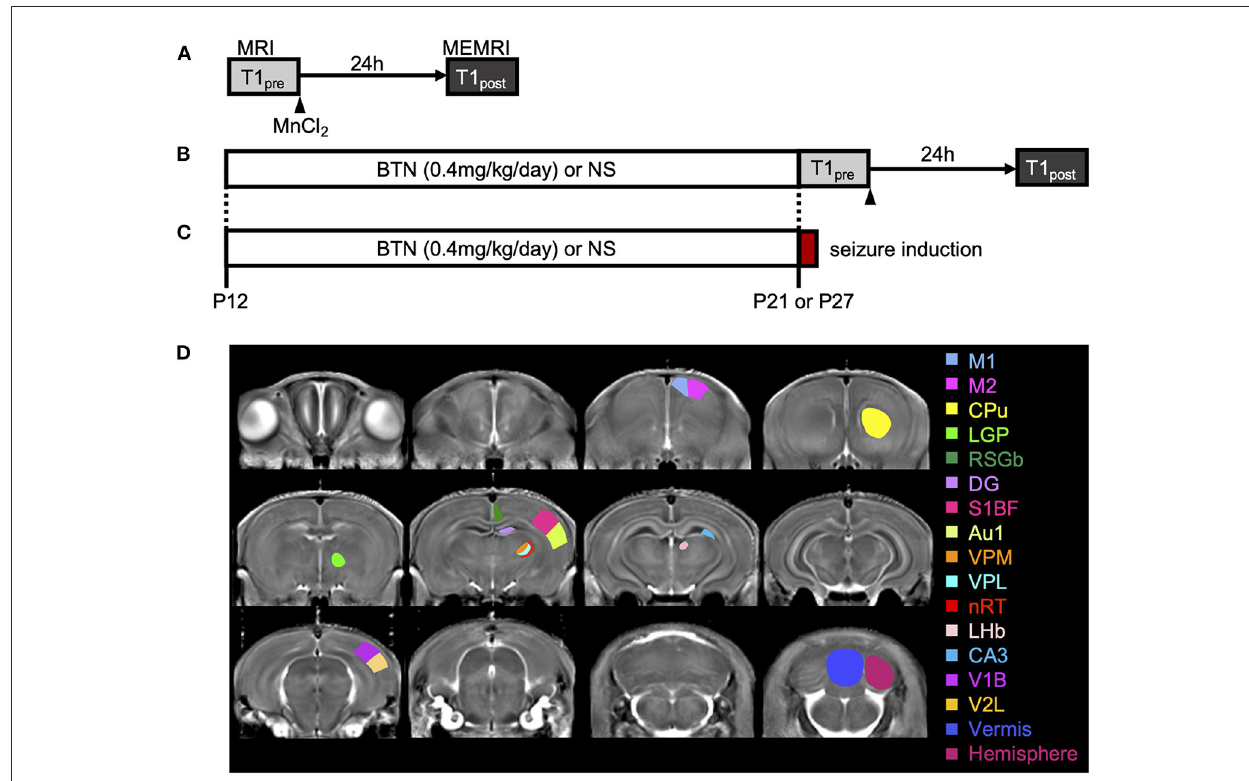
FIGURE2 Schematic diagram of the experiments. (A) Manganese-enhanced magnetic resonance imaging (MEMRI) experiment. Manganese chloride was intraperitoneally administered immediately after the first T1 mapping, which was reconfirmed 24h later. (B) MEMRI experiment in rats treated with bumetanide (BTN) or normal saline (NS). BTN solution (0.2 mg/kg) or an equal volume of NS (4 mL/kg) was injected intraperitoneally twice a day beginning at postnatal day (P) 12, and MEMRI was performed for each rat on P21 or P27. (C) Heat-induced seizure experiment in rats treated with BTN or NS. After daily injections of BTN or NS, seizures were induced in rats by a warm bath at P21 or P27. (D) Representative coronal T1 map and regions of interest. Regions were manually obtained using the Paxinos and Watson atlas. The image shows the average of T1 maps. Colors indicate 17 different brain regions, which are overlaid on averaged images of the MEMRI T1 map. M1, primary motor cortex; M2, secondary motor cortex; CPu, caudate-putamen (striatum); LGP, lateral globus pallidus; RSGb, retrosplenial granular b cortex; DG, dentate gyrus; S1BF, primary somatosensory cortex, barrel field; Au1, primary auditory cortex; VPM, ventral posteromedial thalamic nucleus; VPL, ventral posterolateral thalamic nucleus; nRT, reticular thalamic nucleus; LHb, lateral habenular nucleus; CA3, CA3 field of the hippocampus; V1B, primary visual cortex, binocular area; V2L, secondary visual cortex, lateral area; Vermis, cerebellar vermis; Hemisphere, cerebellar